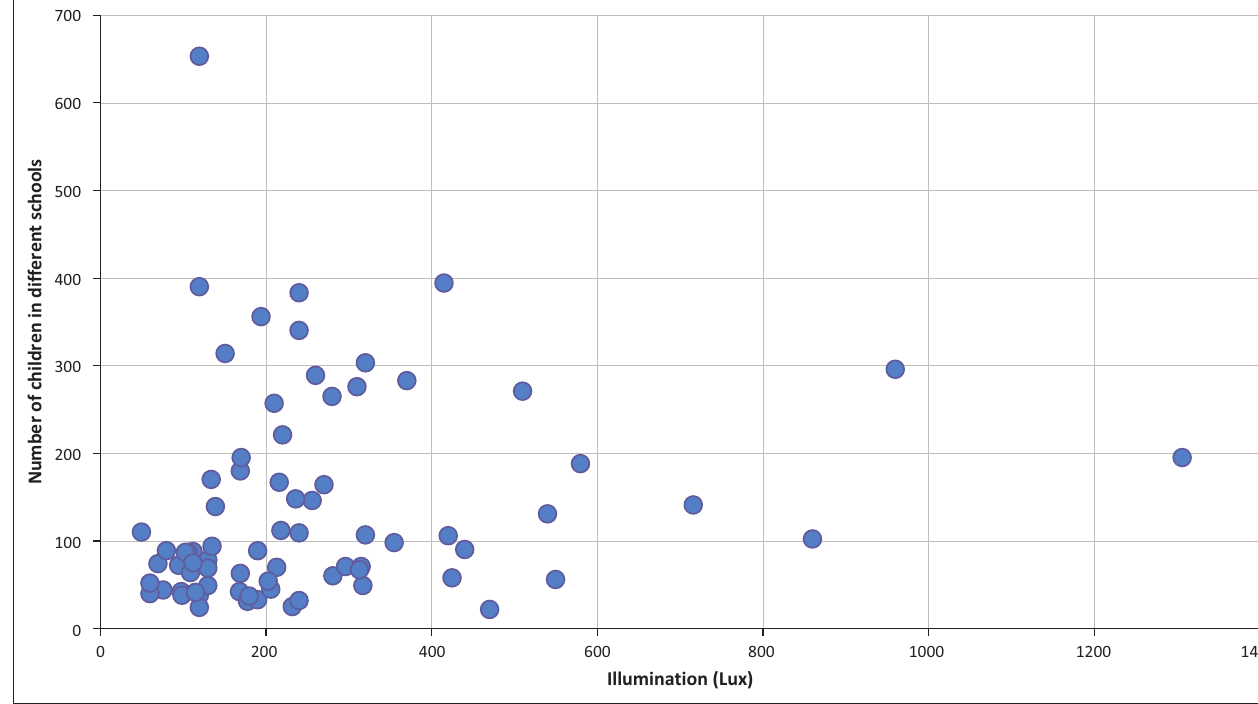
FIGURE 3: Illumination levels in the different schools set-ups.